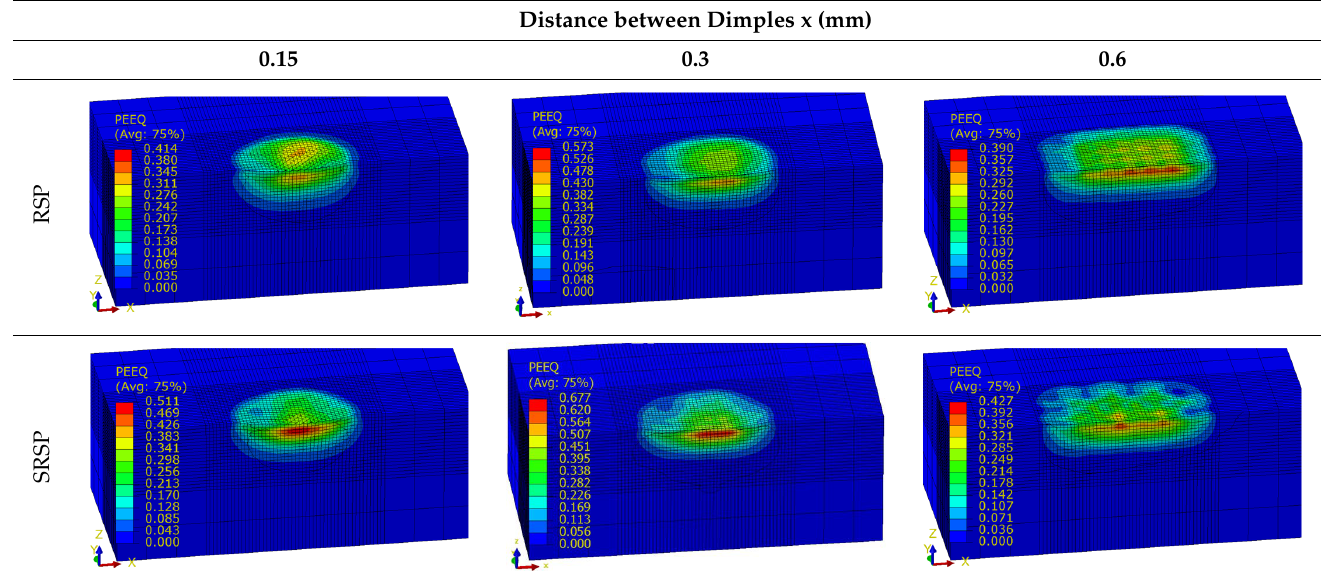
Table 9. Effect of the distance between the dimples on the value of PEEQ equivalent plastic strain after 36 impacts (impact energy E = 100 mJ, ball diameter D = 10 mm).